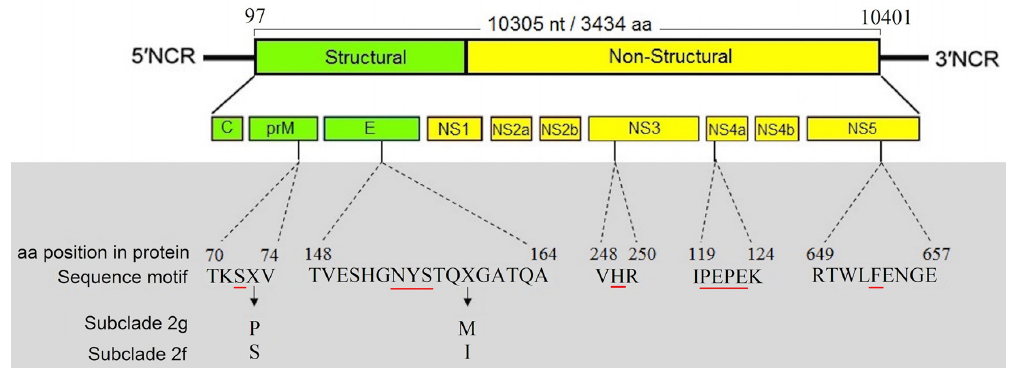
Figure 3. Schematic representation of the genomic structure of West Nile virus (WNV) with genes labeled (white area). Known virulence motifs identified in Iranian WNV specimens with amino acid substitutions in subclade 2g and subclade 2f (grey area). Key codons at each known virulence motifs are labeled by red underline.